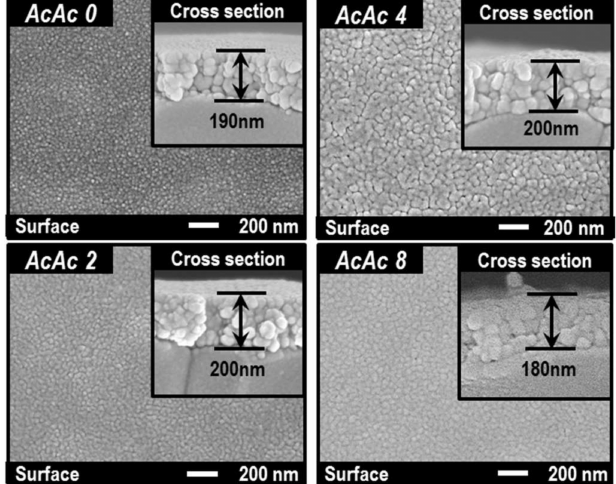
Figure 6. SEM images of the SmFeO 3 thin-films prepared from AcAc0, 2, 4 and 8 precursors at 750 ◦